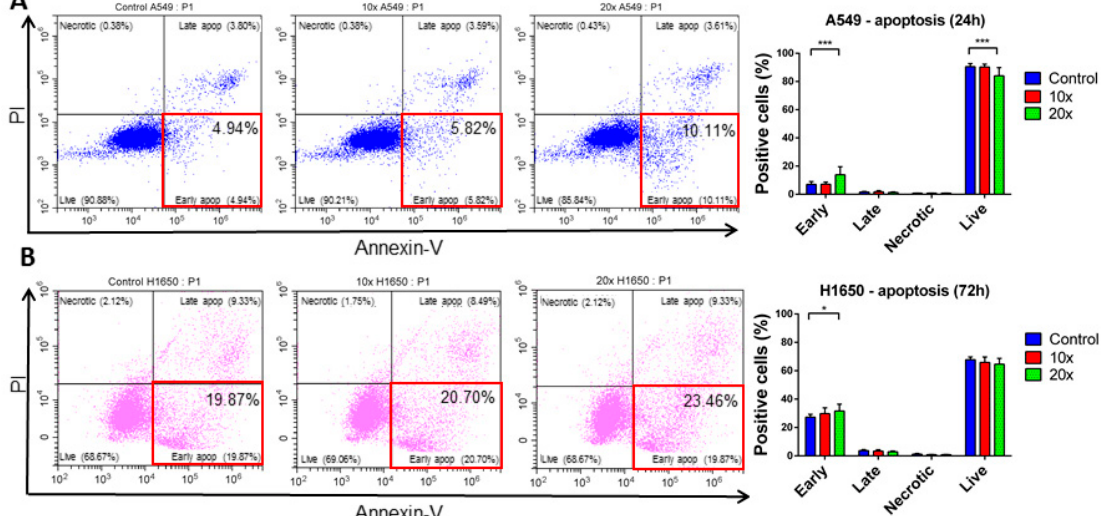
4 Figure 4. Apoptosis detection in A549 and H1650 cells by flow cytometry ( A , B ). Early apoptotic cells (red squared highlighted areas, lower right squares) were significantly elevated at the highest concentration of methyl-donor treated A549 and H1650 cell lines after 24 h ( A ) and 72 h ( B ), respectively, compared to control. Each bar represents the average percentage of positive cells in the early apoptotic, late apoptotic, necrotic, and live cells area from at least 3 repeats ± SD. Statistical significance was plotted as *: p < 0.05; ***: p < 0.001. Early: early apoptotic cells; Late: late apoptotic cells; Necrotic: necrotic cells; Live: live cells. × 10 and × 20 concentrations of